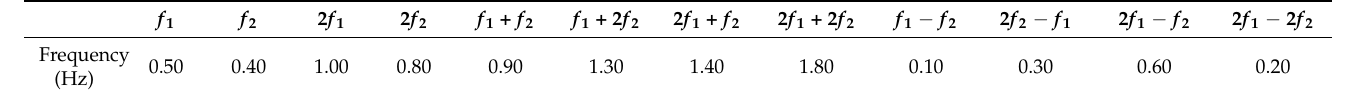
Table 2. Main frequencies of the C1 spectrum analysis under working